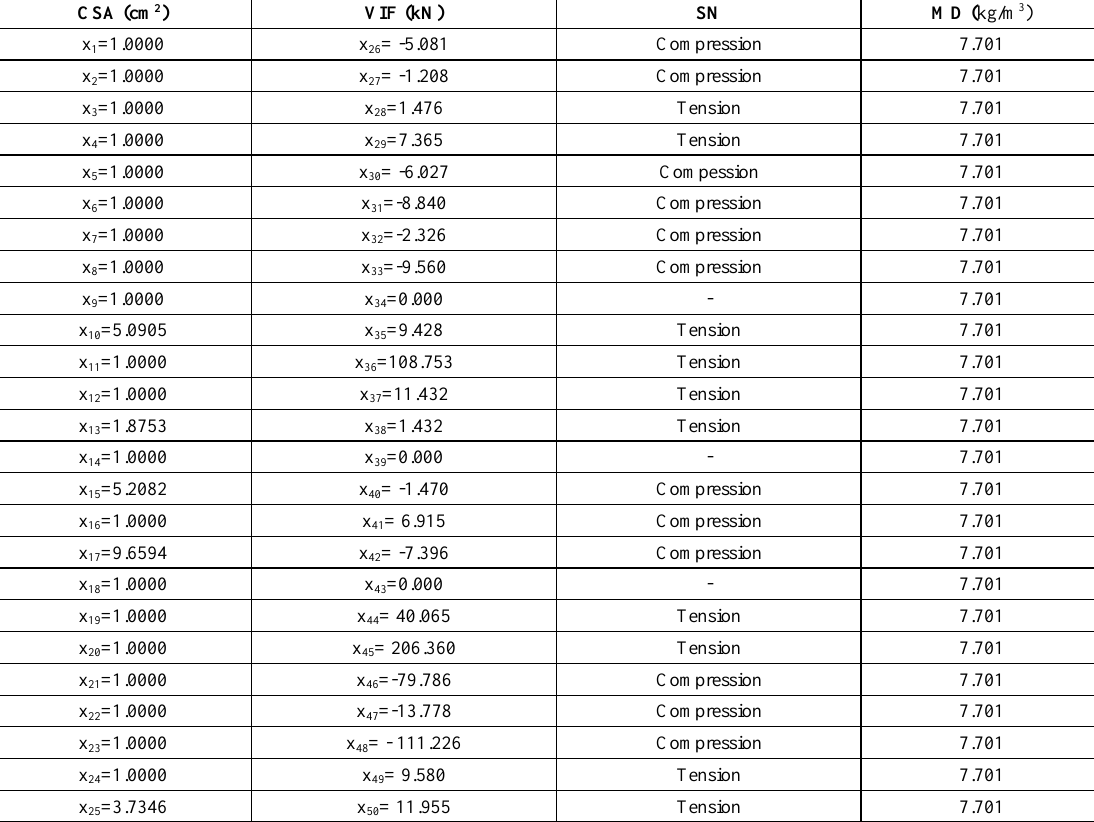
) for the loading case i 1≤i≤25